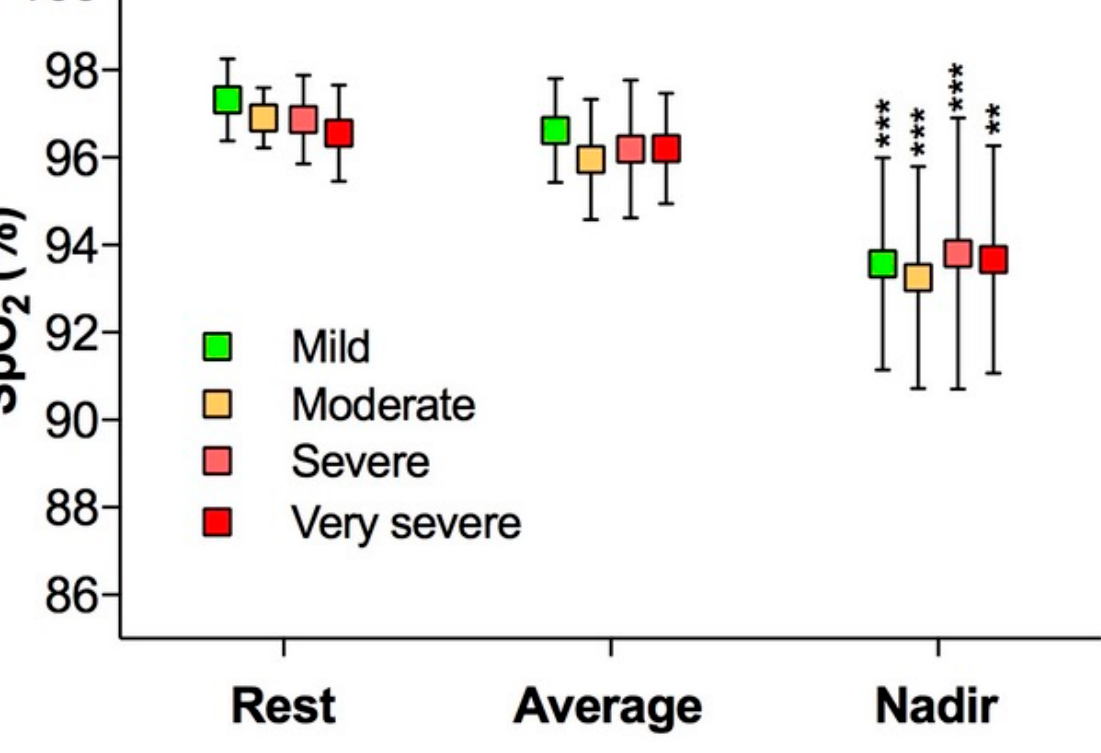
Figure 1. Peripheral saturation at rest (basal), at nadir and the average during the 6-min walk test. Despite the severity, all groups showed a significant desaturation during the test (SpO 2rest-nadir **, p < 0.01; ***, p < 0.001). SpO 2 : Peripheral saturation of oxygen. There was a significant correlation between the DLco, %pr and the DDR and the difference between SpO 2rest-nadir ( R 2 = 0.1487, p = 0.001 and R 2 = 0.0861, p = 0.015, Figure 2), but not with the DLco/VA,